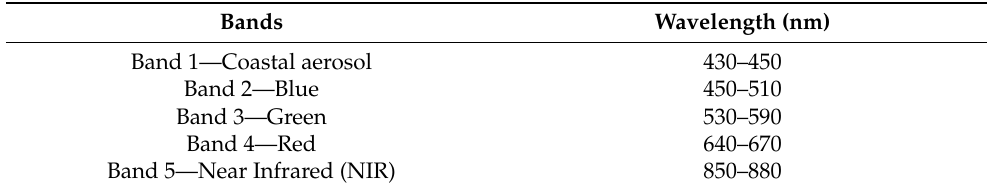
Table 2. Landsat-8 bands.